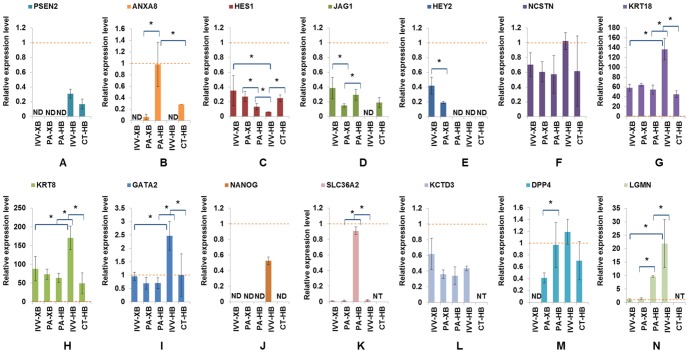
QPCR verification result.QPCR verification result of 14 selected genes. The mRNA expression levels of these genes were normalized with the external control gene (Xeno), and were calculated with 2−ΔΔCt relative quantification. Bar charts showing the relative expression levels of PSEN2, ANXA8, HES1, JAG1, HEY2, NCSTN, KRT18, KRT8, GATA2, NANOG, SLC36A2, KCTD3, DPP4, and LGMN genes in IVV XB, IVV HB, PA XB, PA HB, and CT HB (KCTD3, SLC36A2, and LGMN genes were not tested in CT HB). The relative expression levels of in each sample were standardized with their expression Error bars shows the standard error (*: P < 0.05). Dashed lines indicate 1.0 expression level. ND: not detected. NT: not tested.